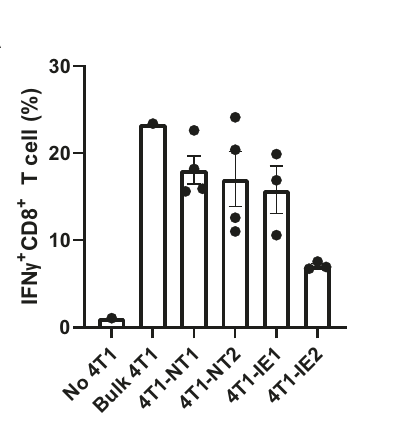
Fig.5|Geneexpressionanalysisofimmunotherapy-resistantclones.A Volcano plot showing differentially expressed genes between parental 4T1 cells and the immunotherapy-enriched 1 (IE1) clone. B Volcano plot showing differentially expressed genes between parental 4T1 cells and the immunotherapy-enriched 2 (IE2) clone. C Expression of indicated MHC-related genes, measured as transcripts per million (TPM), in the parental 4T1 population and in indicated cell clones; FDR calculated using EdgeR with Benjamini – Hochberg multiple testing correction. Three independent cell lines in 4T1-IE1 and 4T1-IE2 groups and four independent cell lines in all other groups. Data presented as mean±SEM. D MHC-I protein expressionasquanti fi edby fl owcytometryintheindicatedclonesandtheparental